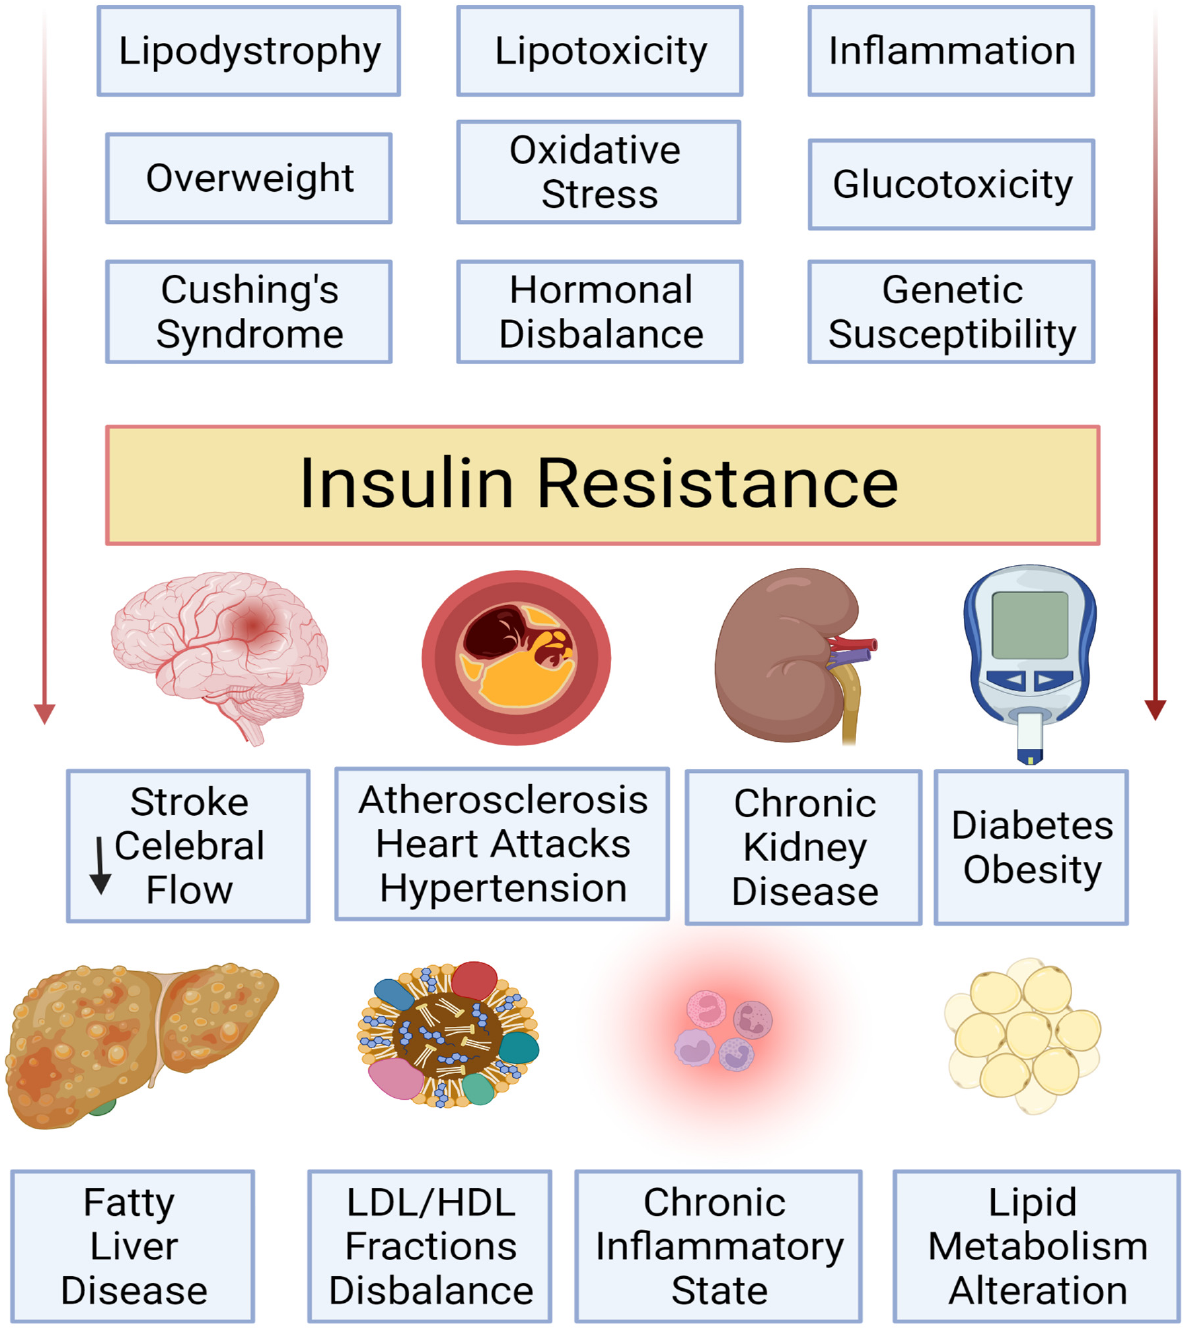
Figure 1. Overview of insights into the most common causes and main outcomes of IR. Insulin resistance is caused by a plethora of metabolic changes in lipid, glucose and hormone status as well as chronic oxidative stress and a chronic inflammatory state [2,3]. The main outcomes include, but are not limited to, increased risk of CVD, alterations in lipid and glucose metabolism, and lower life quality in general [4,5].